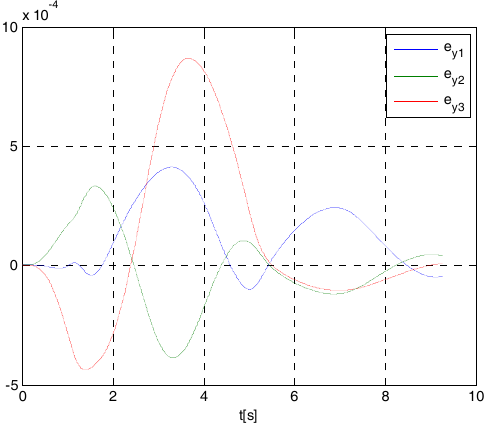
Figure 26. Time histories of the errors with the controller (71).